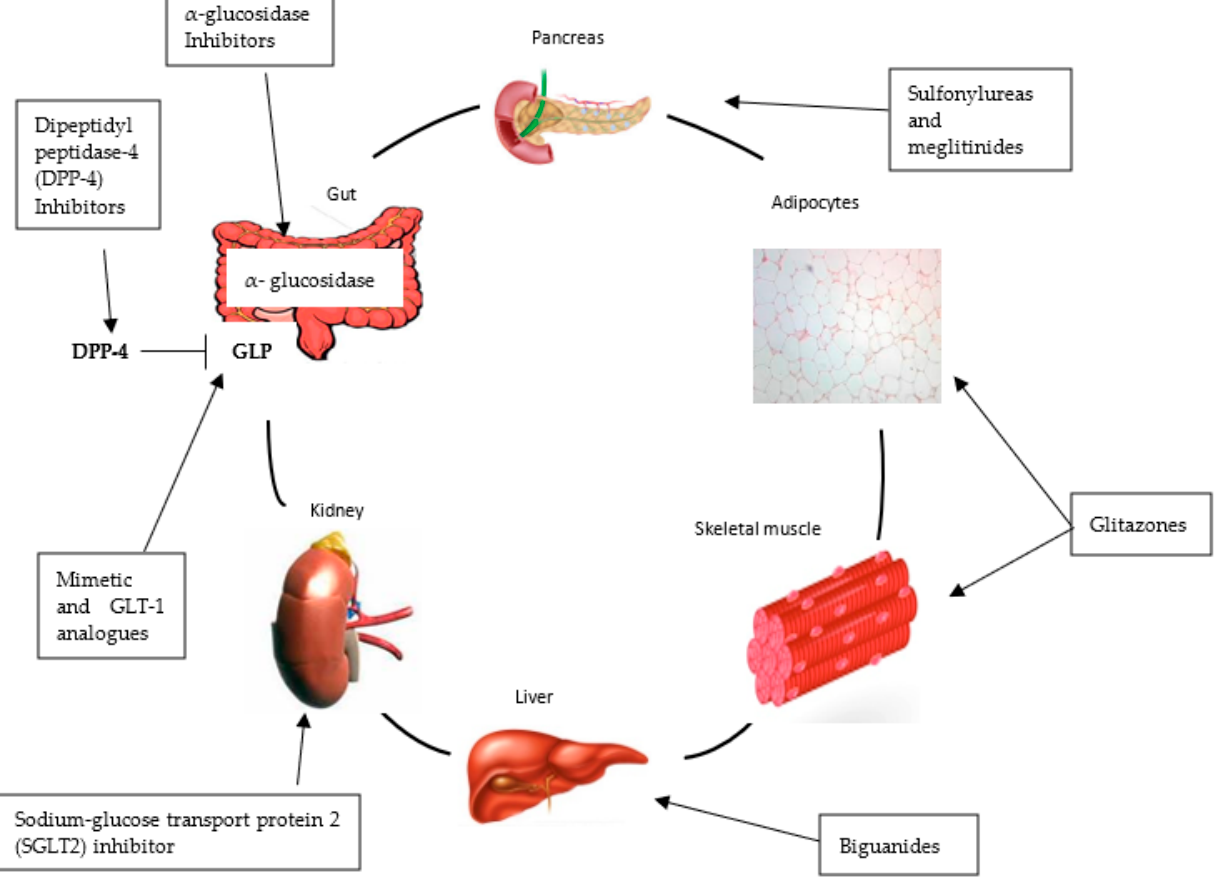
Figure 1. Target tissue of current antidiabetic drugs.